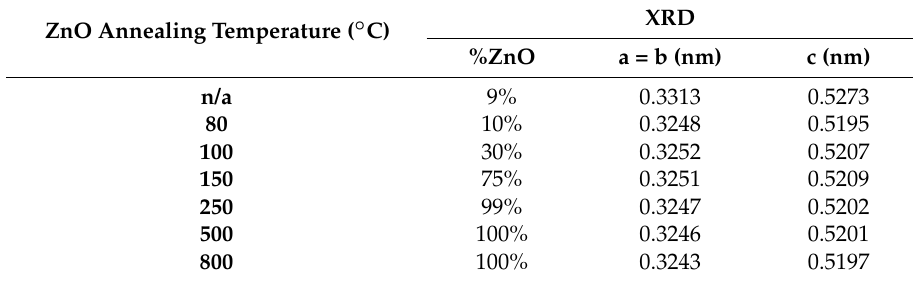
Table 1. Percentage of ZnO composition in the raw synthesis product and the lattice parameters (a, b and c) of ZnO samples before and after annealing at different temperatures.